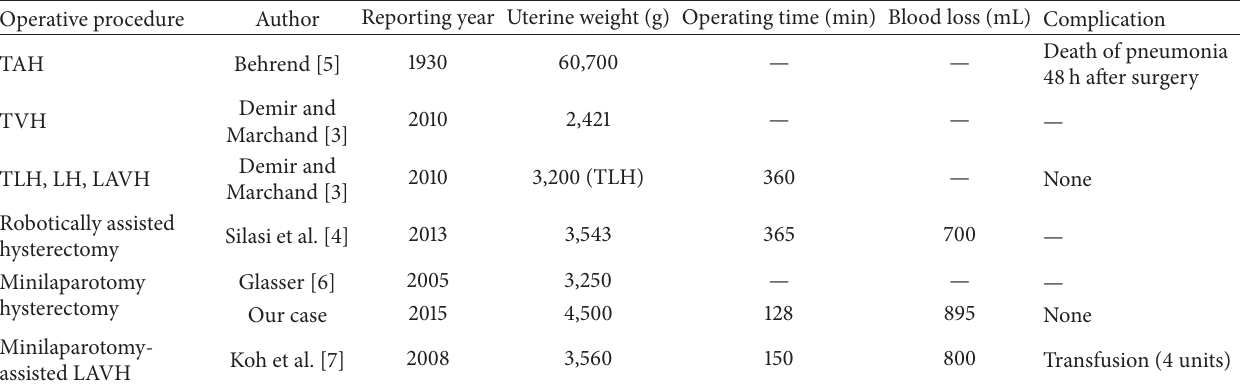
Figure 3: Photographs during the operation. (a) Wedge morcellation of intramural myoma nodule of uterine corpus. (b) Resected peduncle of a subserosal myoma nodule (arrow). (c) Hysterectomy (arrow). (d) The length of the abdominal wound was 8.5 cm at the end of the surgery. Table 1: Heaviest uterine weight removed by various operative